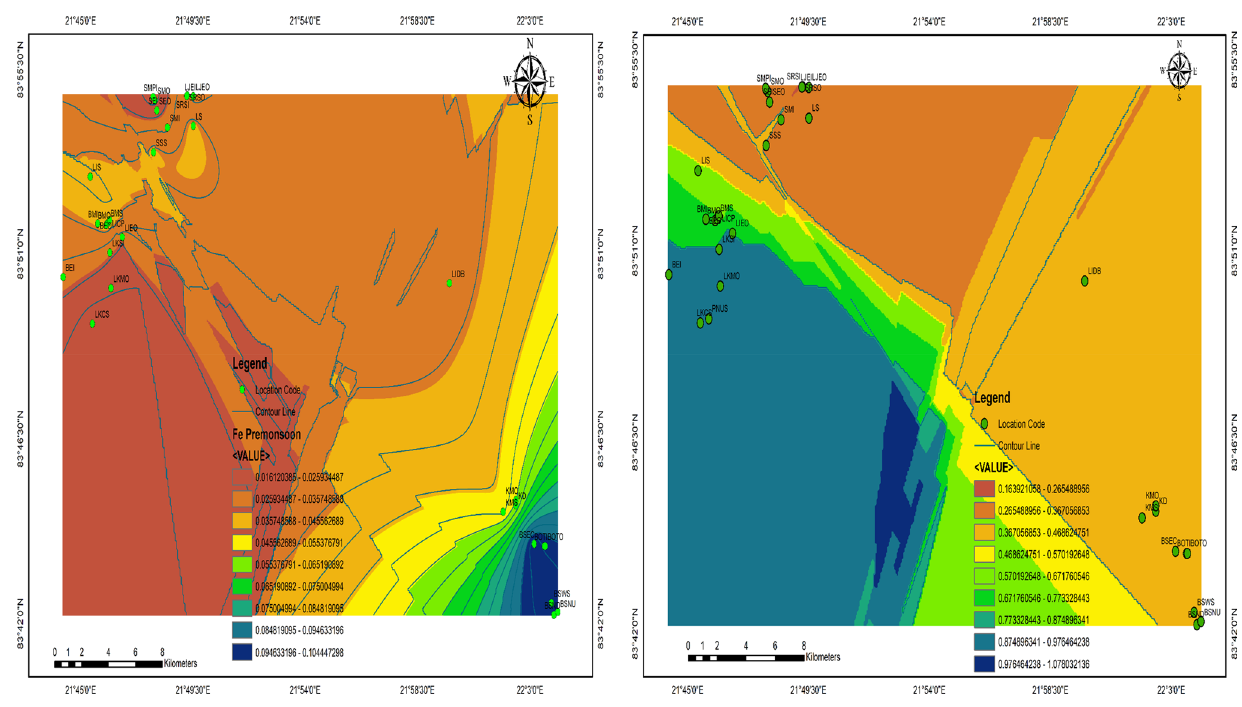
Fig. 11 Contour map for Iron concentration in water samples during premonsoon and monsoon season